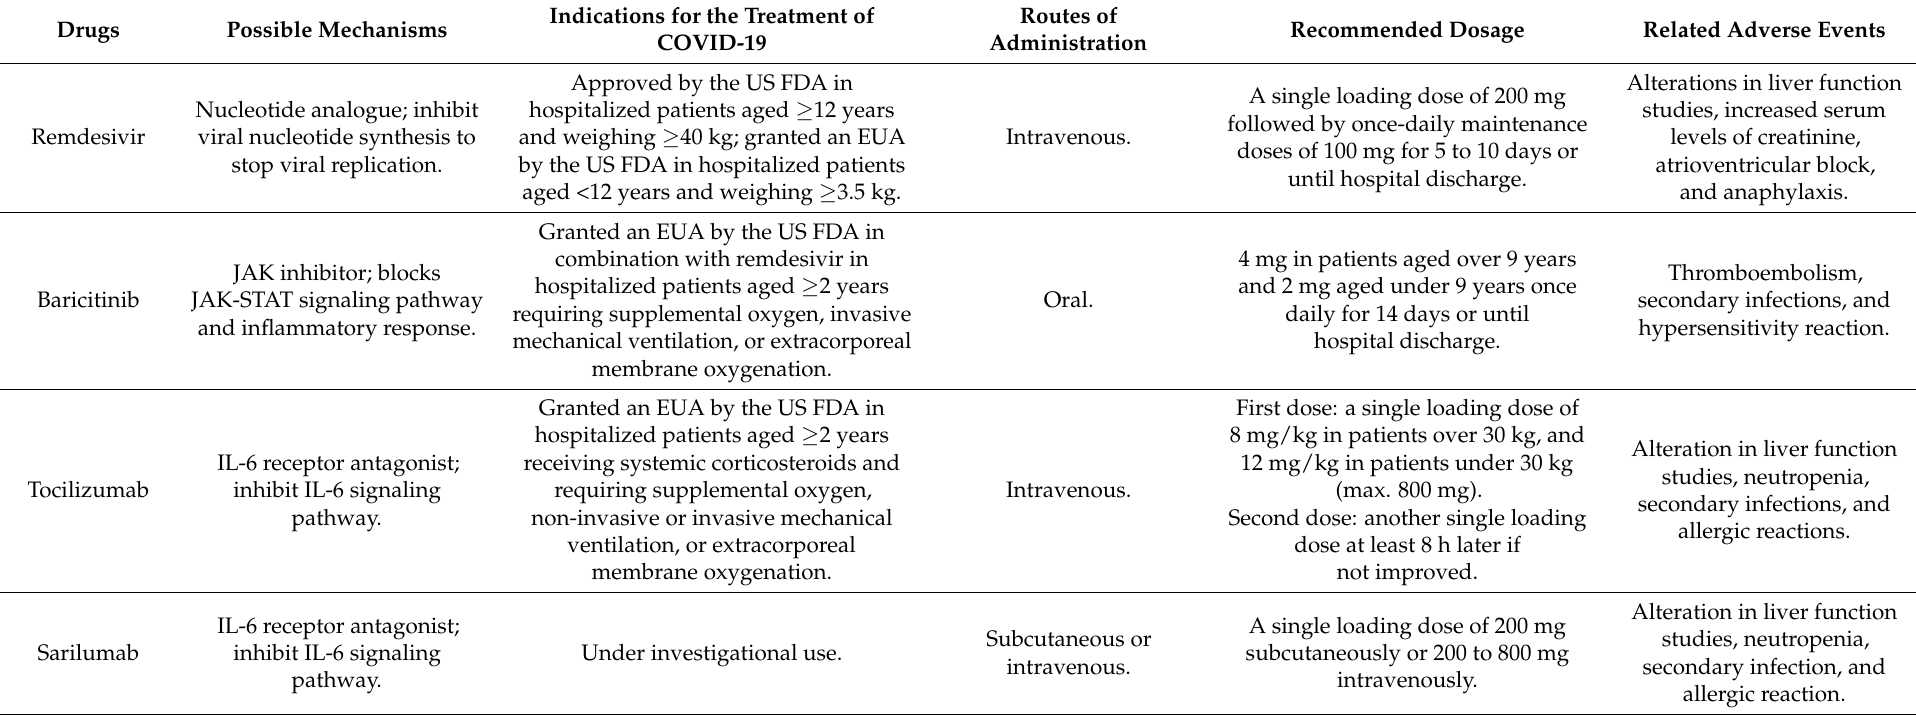
Table 3. The summary of available drugs for the treatment of moderate-to-severe